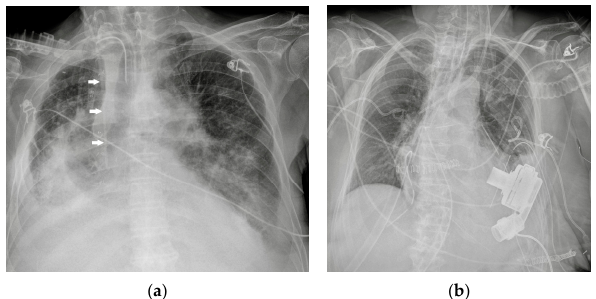
Figure 1. Potential confounding factors when checking for devices on a CXR. ( a ) Anteroposterior CXR of a right-sided rotated patient can simulate the dislocation of the central venous catheter (white arrows). ( b ) Anteroposterior CXR of a patient with multiple devices and external EKG leads.